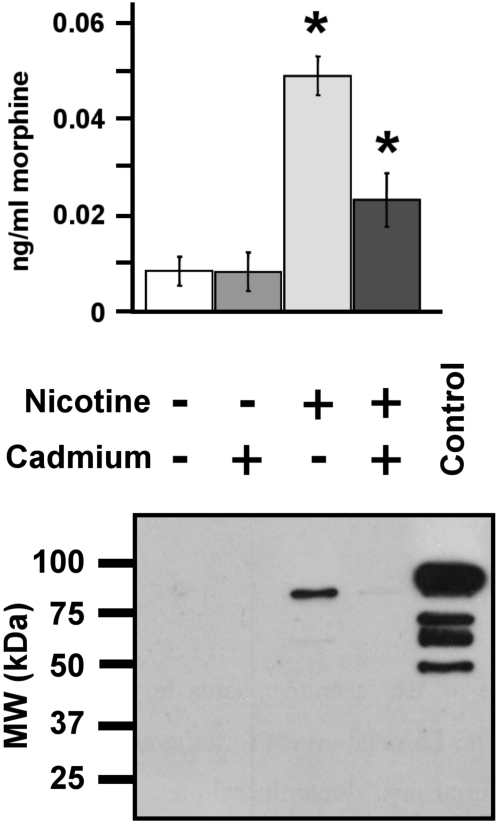
Characterization of morphine secretion from SH-SY5Y cells.
Upper panel. The amount of morphine secreted into the culture medium was determined after stimulating 4×105 cells with 100 µM of nicotine with or without cadmium (200 µM) for 24 h. The basal secretion level was obtained from cells incubated without nicotine at the same time (n = 6). Amounts of secreted morphine in the nicotine and nicotine+cadmium groups were statistically different and were both different from the two control groups (no nicotine and no nicotine+cadmium; Mann-Whitney test, * p<0.01). Lower panel. The efficiency of secretion was assessed by monitoring the secretion of chromogranin B (CGB), an intra-LDC vesicle protein [28], by Western blot analysis. A positive control, intragranular protein matrix from bovine chromaffin cells (10 µg), was loaded in order to evaluate the molecular weight of the entire CGB (80 kDa).